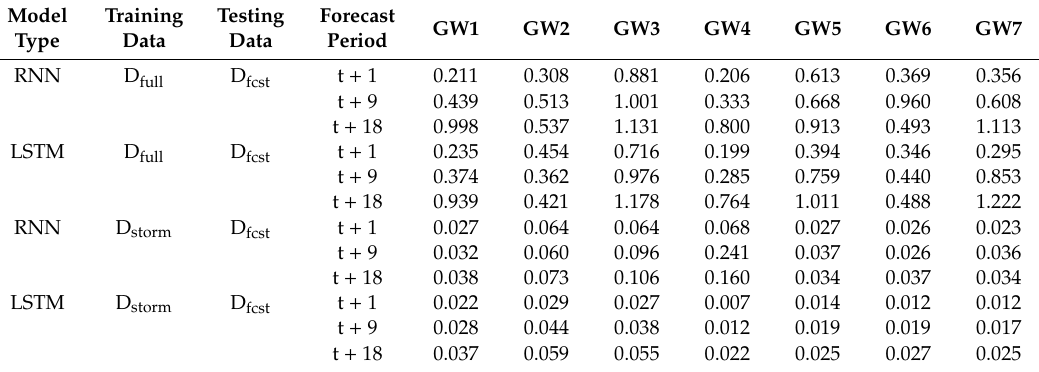
Table A2. Mean MAE values for each model type and training dataset treatment at each well and forecast period when tested on forecast data D fcst